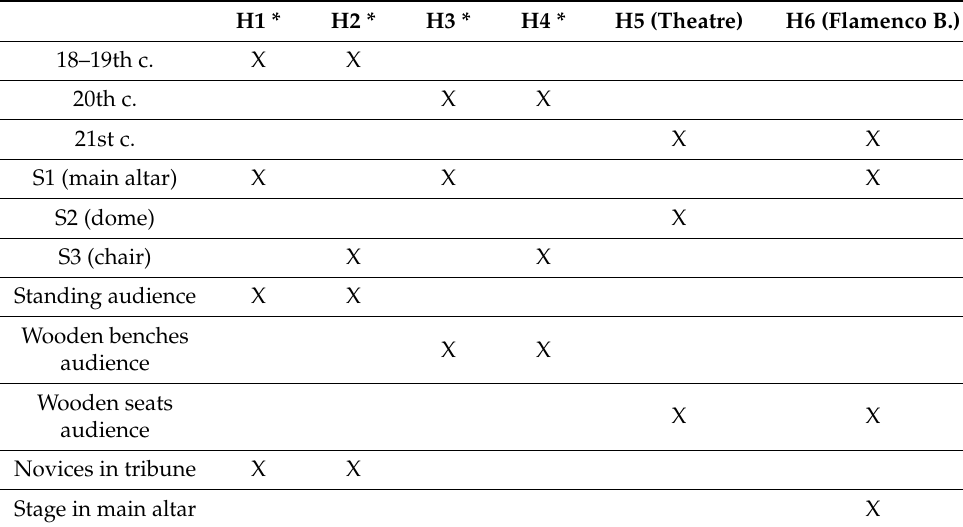
Table 6. Evolutionary hypotheses (*